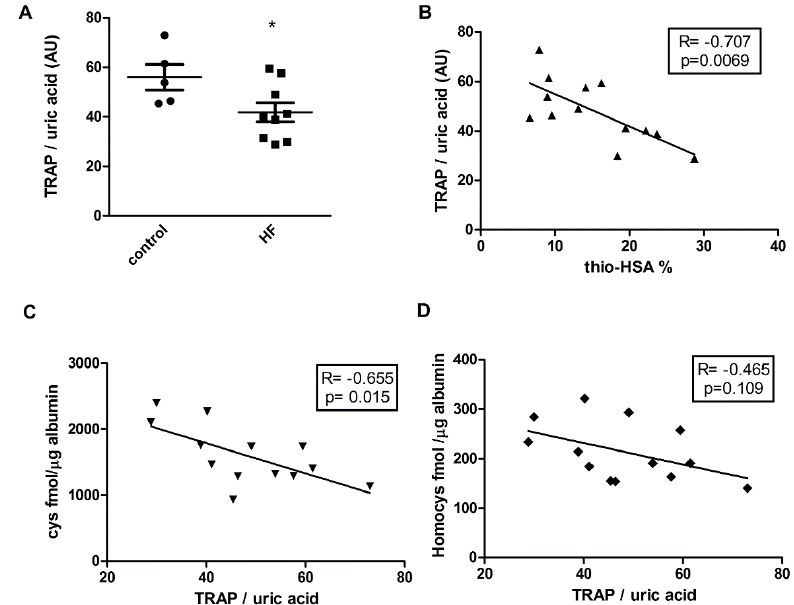
Figure 3. Correlation between S-thiolation and antioxidant properties of HSA. ( A ) Results from the TRAP assay performed on control and HF subjects. Data are expressed as lag-phase of TRAP assay/uric acid plasma concentration ( B – D ) Correlation between antioxidant activity and percentage of thiolated albumin, cysteine, and homocysteine bound to HSA. * p < 0.05 vs control.